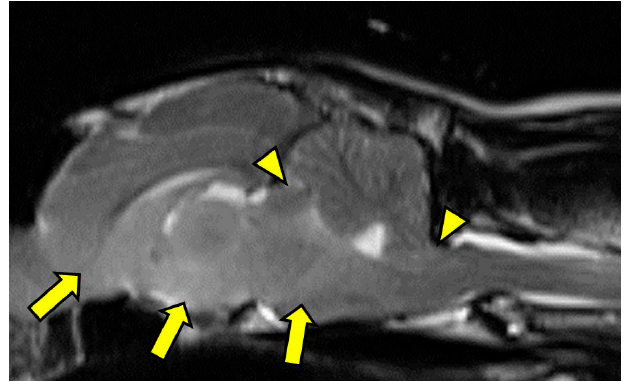
Figure 2. T2-weighted midline sagittal image showing caudal transtentorial herniation of the midbrain through the osseous tentorium and caudal herniation of the cerebellum through the foramen magnum (arrowheads). Additionally, there is an ill-defined, mildly hyperintense mass effect in the ventral aspect of forebrain including the caudal nucleus of the thalamus, interthalamic adhesion, colliculi, and midbrain (arrows). MRI scan.